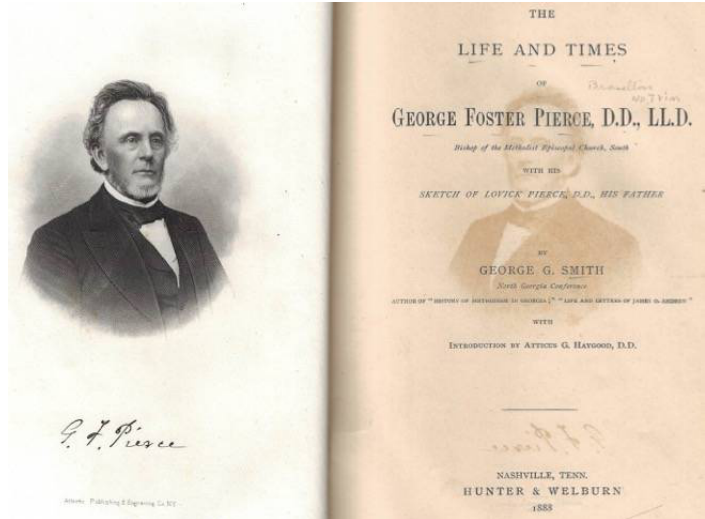
Figure 9. George Foster Pierce and cover page of George Smith’s 1888 memorial to Pierce. Published after the end of Reconstruction and an important source of the life of Pierce, the book contains many of Pierce’s original writings, including letters and sermons, as well as the author’s own memorializing commentary.